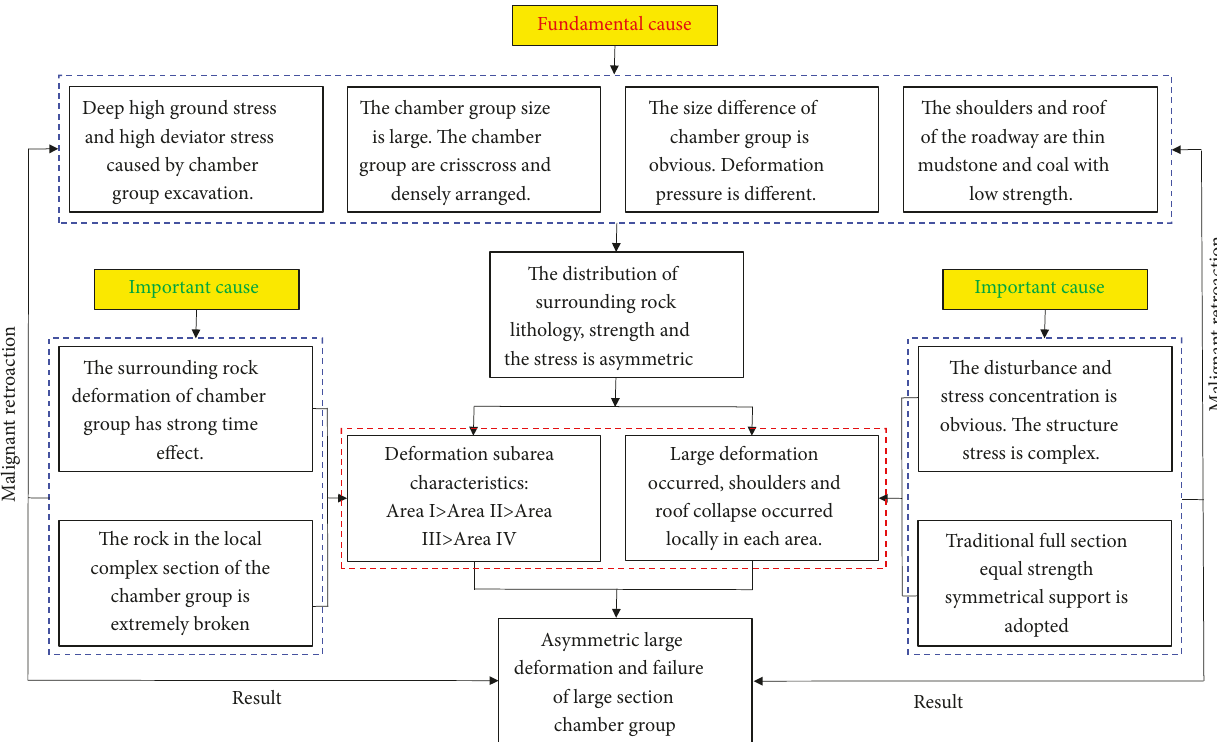
Figure 8: Asymmetric deformation and failure mechanism of surrounding rock of chamber